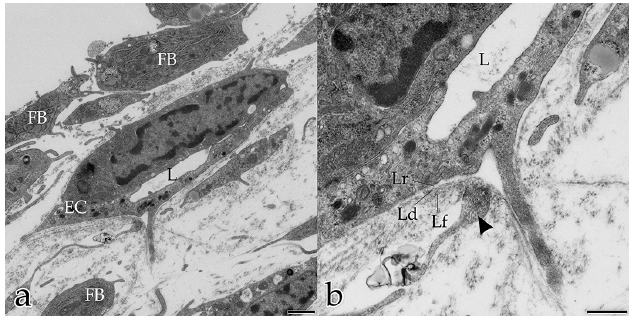
Figure 4. Coculture of ECs with FBs after 5 days: ( a , b ) cross section of a tube surrounded by FBs. Note the lumen (L). The BM surrounds the external surface of the endothelial tube; ( b ) magnification of ( a ): Note structures equivalent to the lamina rara (Lr), lamina densa (Ld), and lamina fibroreticularis (Lf) of the BM. Fibroblast protrusion (arrowhead) contacting the degrading BM as well as the sprouting EC. ( a ) Bar: 1.000 nm; ( b ) Bar: 500 nm.